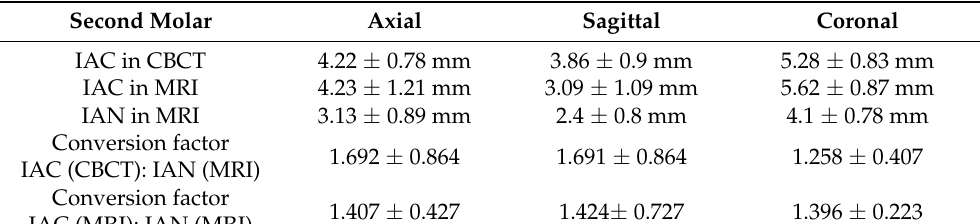
Table 5. The maximal diameter expansion of the IAC in CBCT and in MRI and the IAN in MRI was determined in the axial, sagittal, and coronal plane at the level of the second molar. A conversion factor between IAC and IAN using the two imaging modalities was determined.